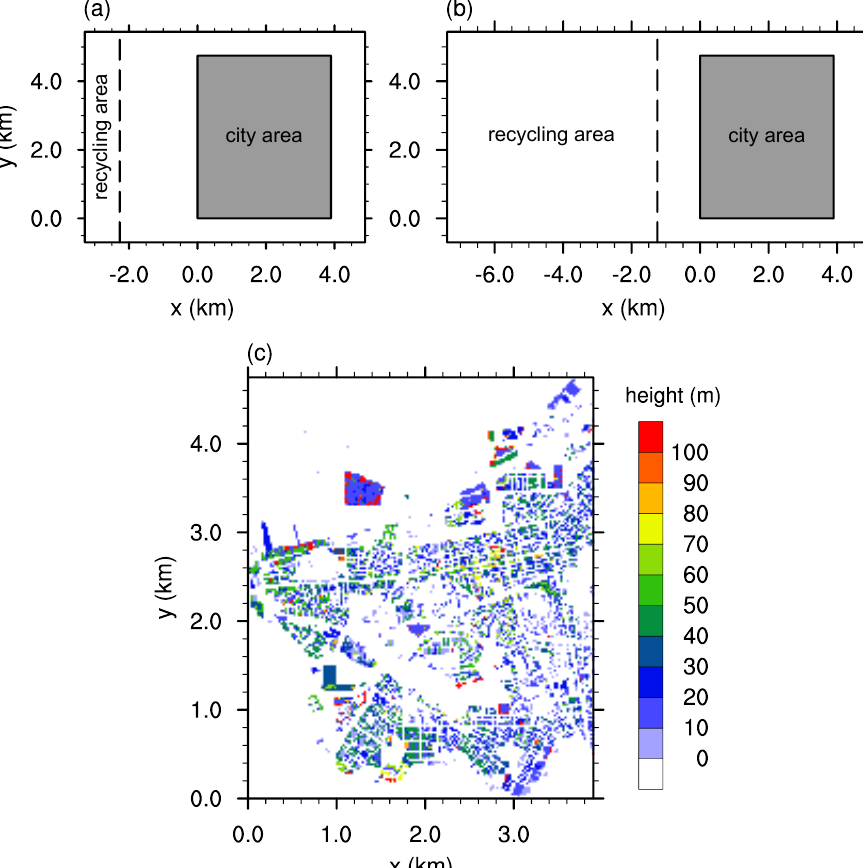
Figure 1. Domain setup for the ( a ) neutral case and ( b ) unstable case; building height information is depicted in ( c ). The dashed line marks the recycling area. The gray rectangle marks the city area shown in detail in ( c